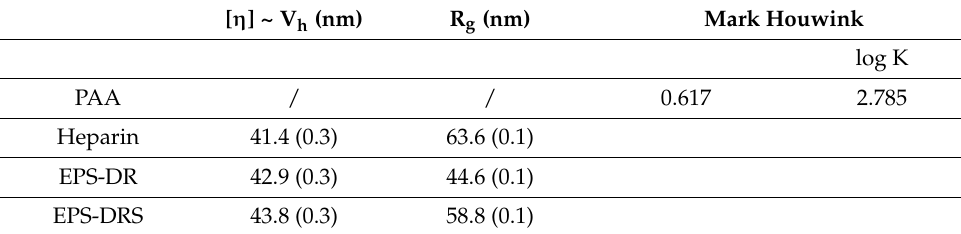
Table 4. Size information summary. The values in the brackets correspond to the